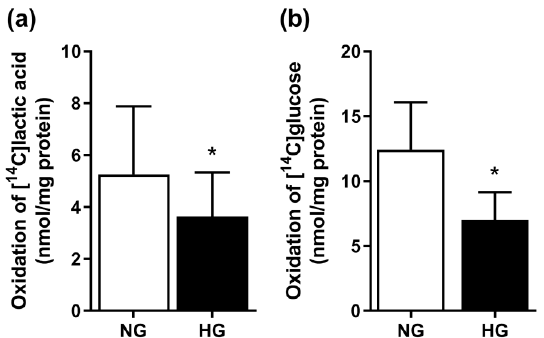
Figure 1. Effects of hyperglycemia on lactic acid and glucose oxidation. Myotubes were exposed to